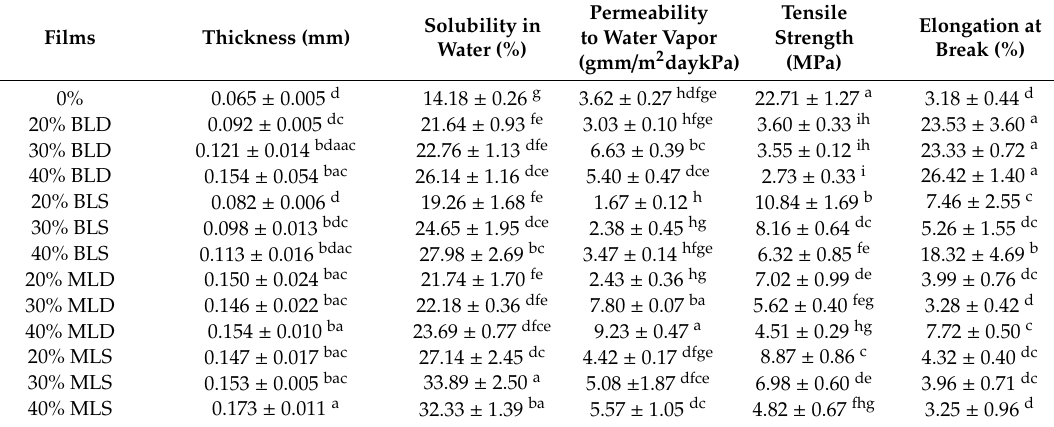
Table 5. Thickness (mm), water solubility (%), water vapour permeability (g.mm / m 2 .day.kPa), tensile strength (MPa) and elongation at break (%) of films with 0%, 20%, 30% and 40% of freeze-dried blackberry pulp (BL) and the freeze-dried microencapsulated blackberry pulp (ML) incorporated directly (D) and by sprinkling (S). Results of the control film characterization (0%) were published by Nogueira, Fakhouri and Oliveira